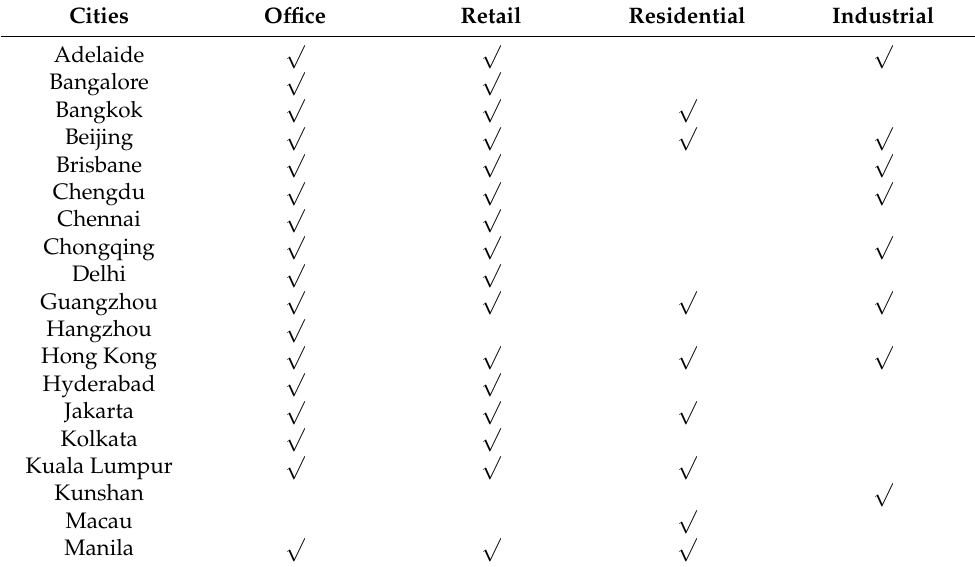
Table 1. List of Cities and Property Sectors. This table presents the list of cities and property sectors covered by the study with data from